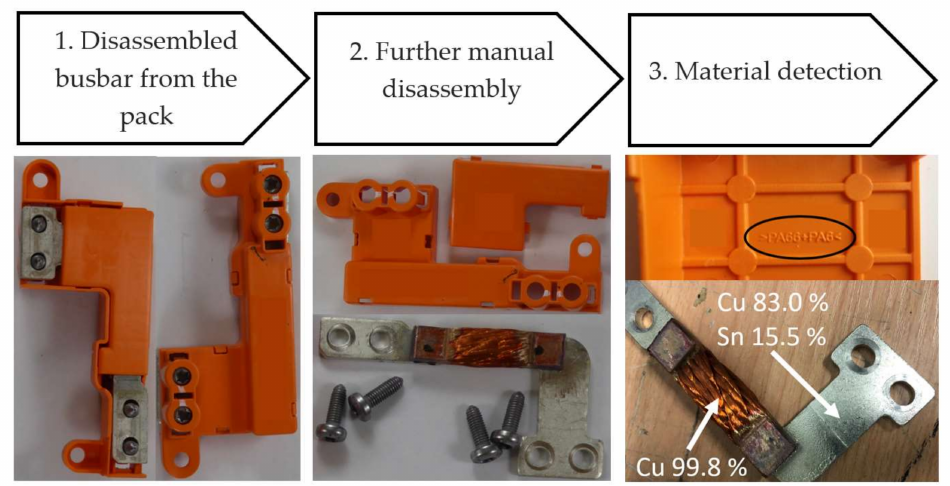
Figure 22. Illustration of the manual disassembly process of the insulated busbars and material